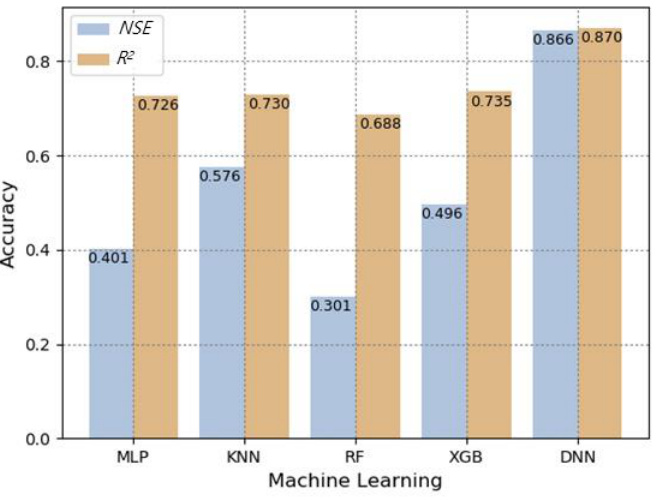
Figure 7. Comparison of prediction accuracy results by machine learning models in test sites.